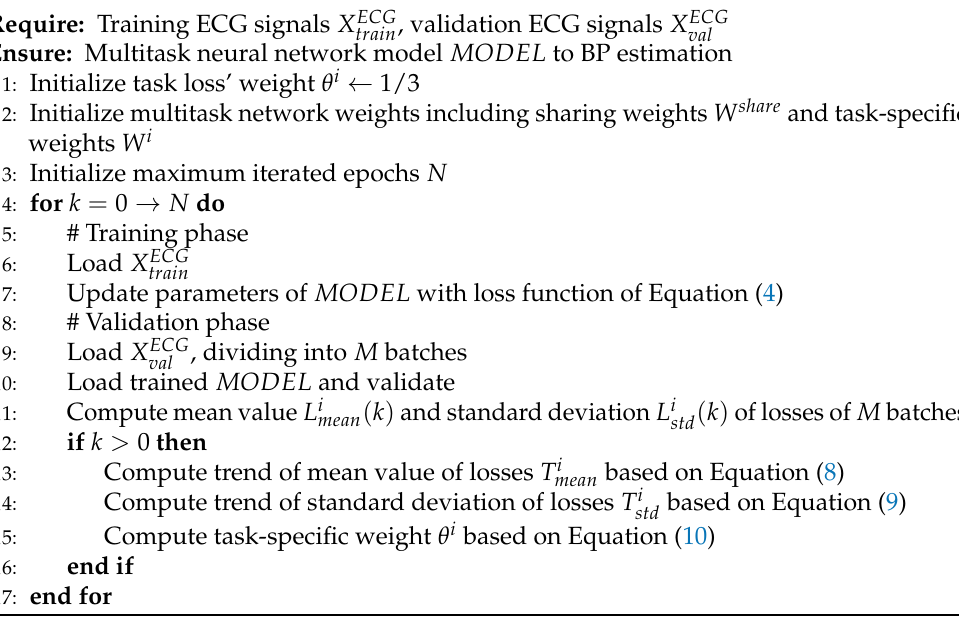
Algorithm 1 Training the proposed adaptive weighted multitask